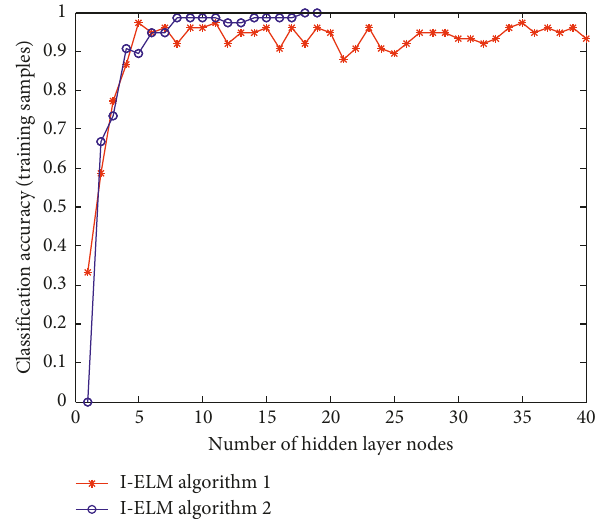
Figure 4: Comparison between I-ELM 1 and I-ELM 2 about classification accuracy updating curves of training samples for the iris data